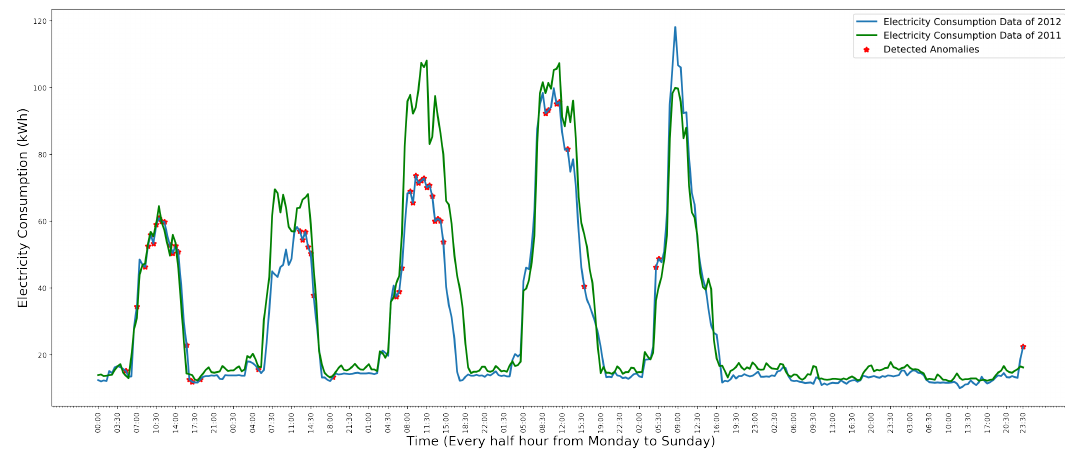
Figure 9. Low precision of the Gaussian kernel distribution model. Adapted from [8].